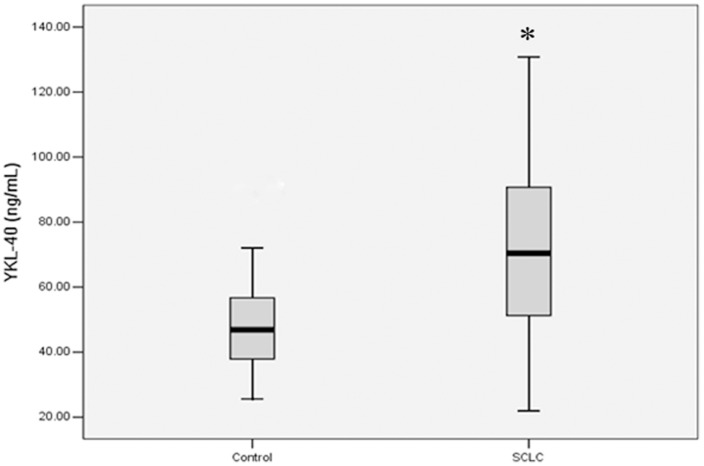
Pre-chemotherapy serum YKL-40 levels in SCLC patients and healthy controls.Among 120 SCLC patients, the serum levels of YKL-40 were (72.06±27.48) ng/mL, which were significantly higher than (48.41±13.63) ng/mL in healthy controls (p<0.001, t-test).